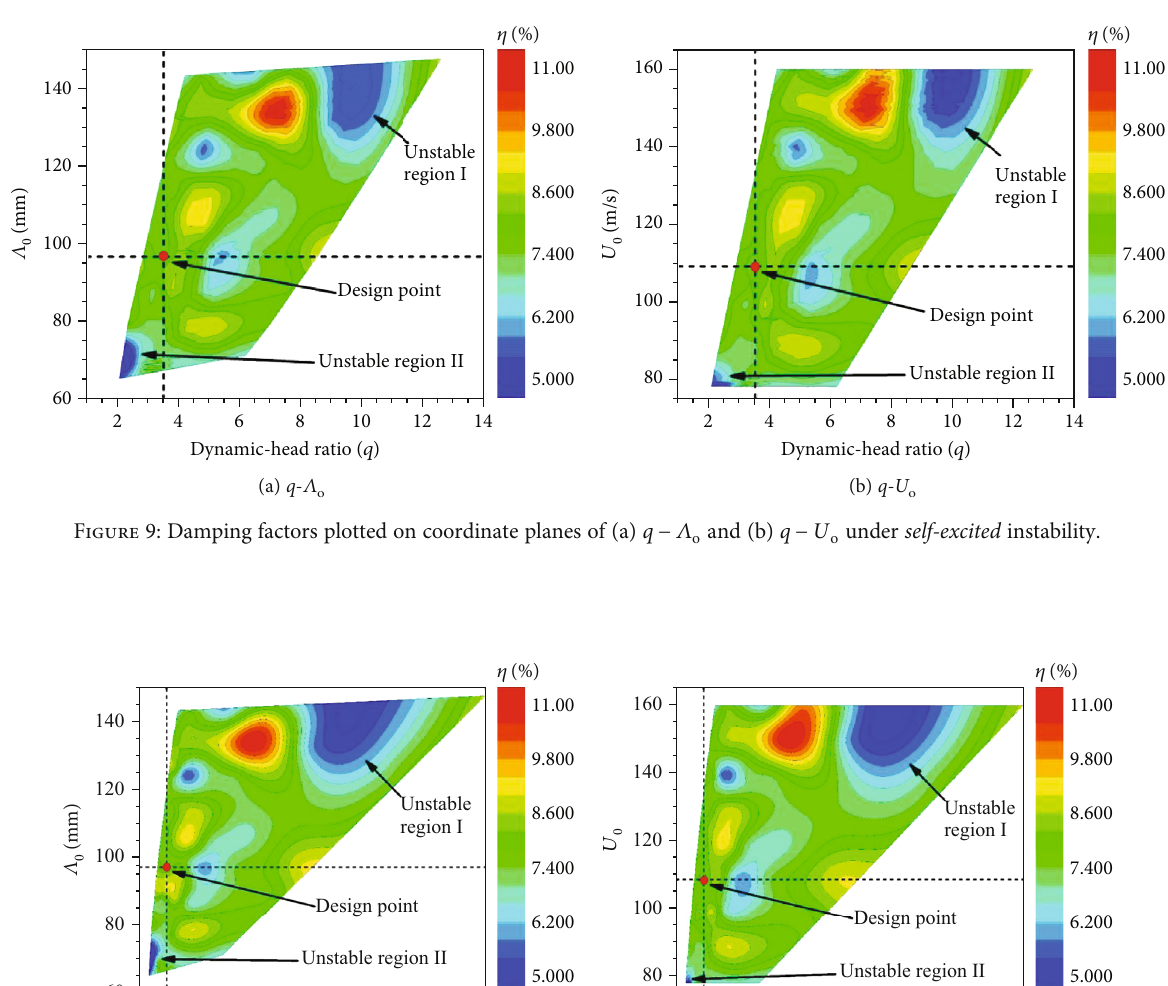
Figure 10: Damping factors plotted on coordinate planes of (a) MFR − Λ